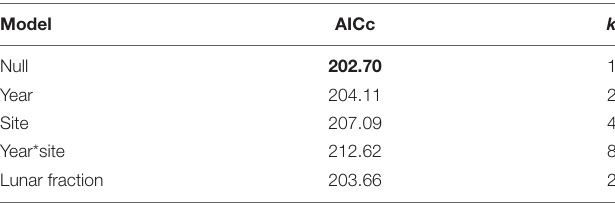
TABLE 3 | Model selection results for nest-at-risk models that do not involve an angle of